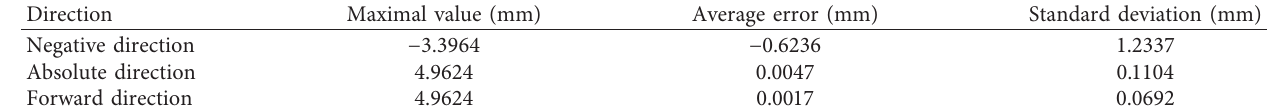
Table 3: Evaluation and analysis of the point cloud by our proposed method for Figure 13.